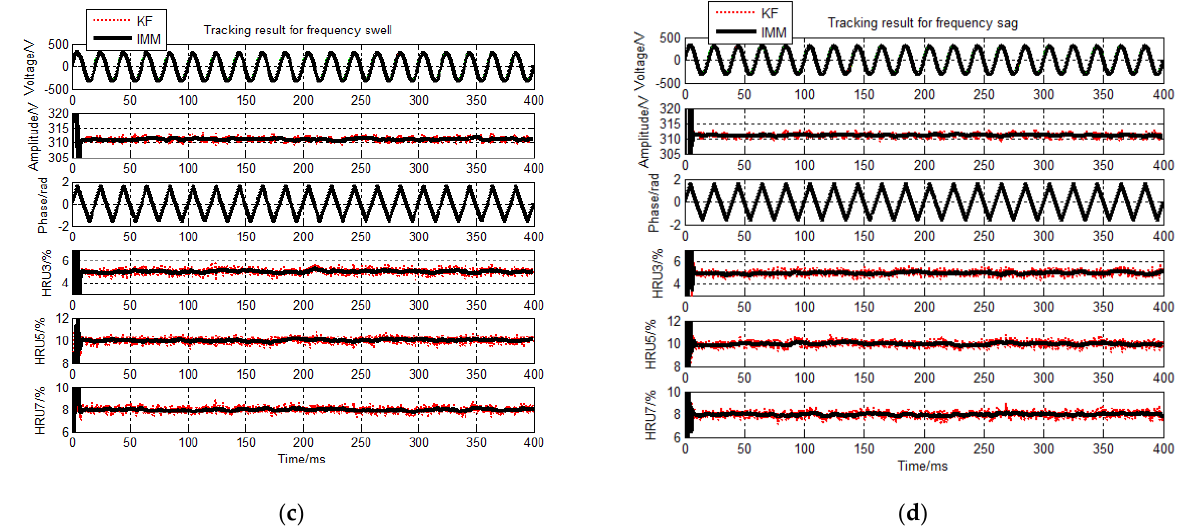
Figure 8. Simulation tracking results for voltage frequency slight fluctuations. ( a ) Simulation tracking results for frequency 49.98 Hz; ( b ) Simulation tracking results for frequency 50.02 Hz; ( c ) Simulation tracking results for frequency swell; ( d ) Simulation tracking results for frequency sag.